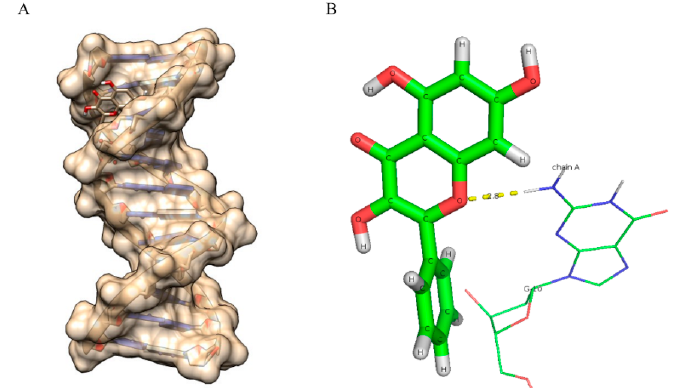
Figure 10 . Molecularly docked structure of galangin with B-DNA. ( A ) Surface view interaction of galangin with B-DNA; ( B ) Hydrogen bonding interactions (1) and distance in Å of galangin with Table 5. Hydrogen bonds and binding energy data obtained from molecular docking procedure of five docked ligands with B-DNA.